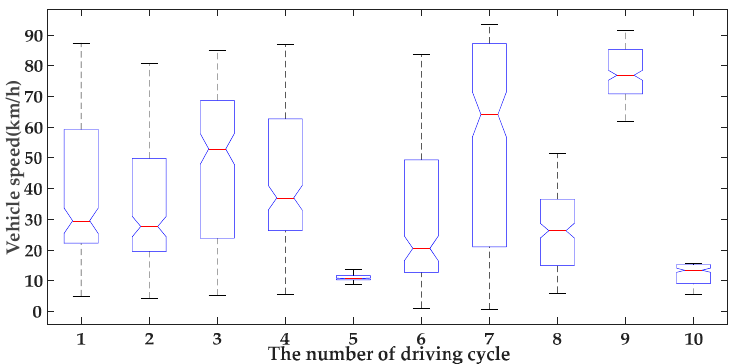
Figure 4. Box diagram of average speed in Kruskal-Wallis test.